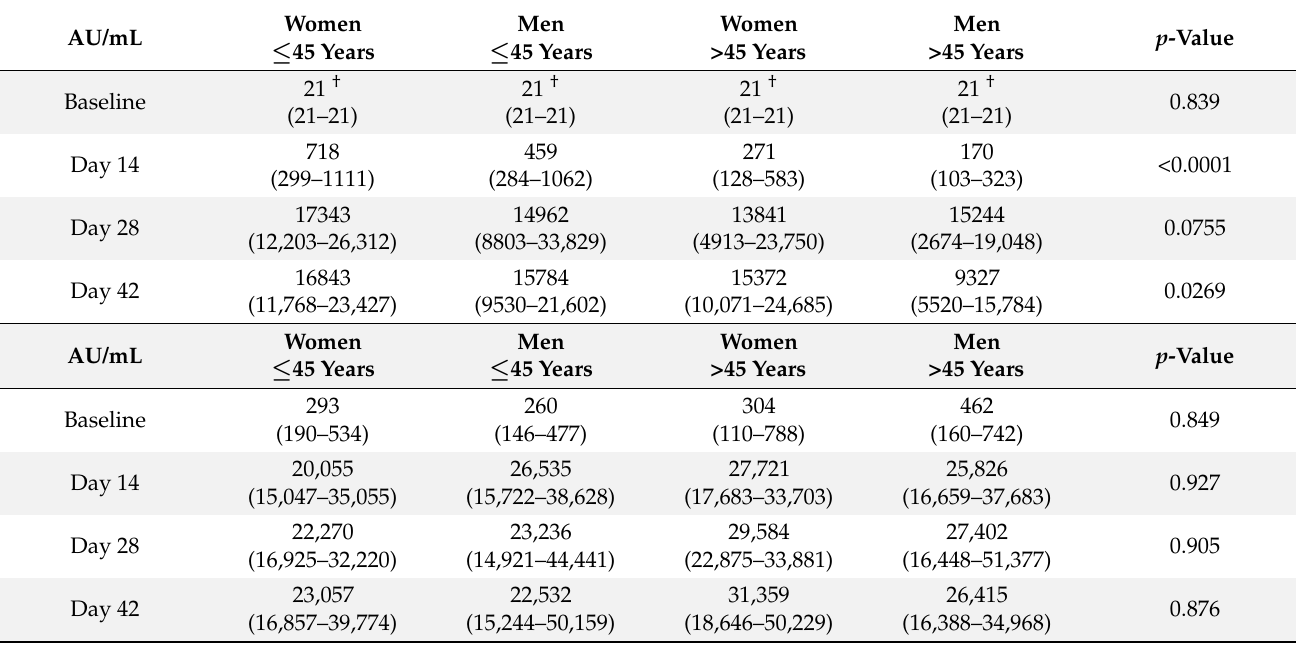
Table 2. Median anti-Spike/RBD values at several time-points according to previous SARS-CoV-2 status, sex and age ( ≤ or > to 45 years).